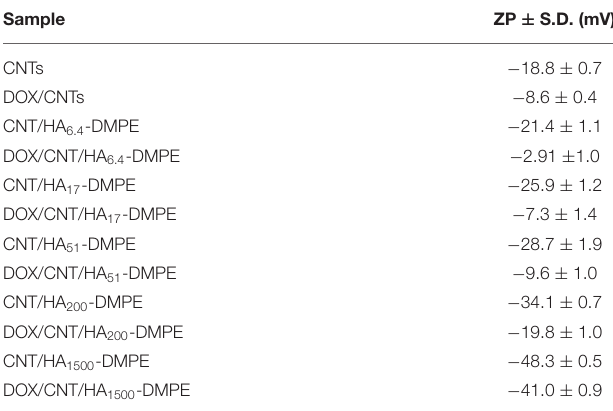
TABLE 1 | Zeta potential (ZP) values of the different functionalized CNTs.